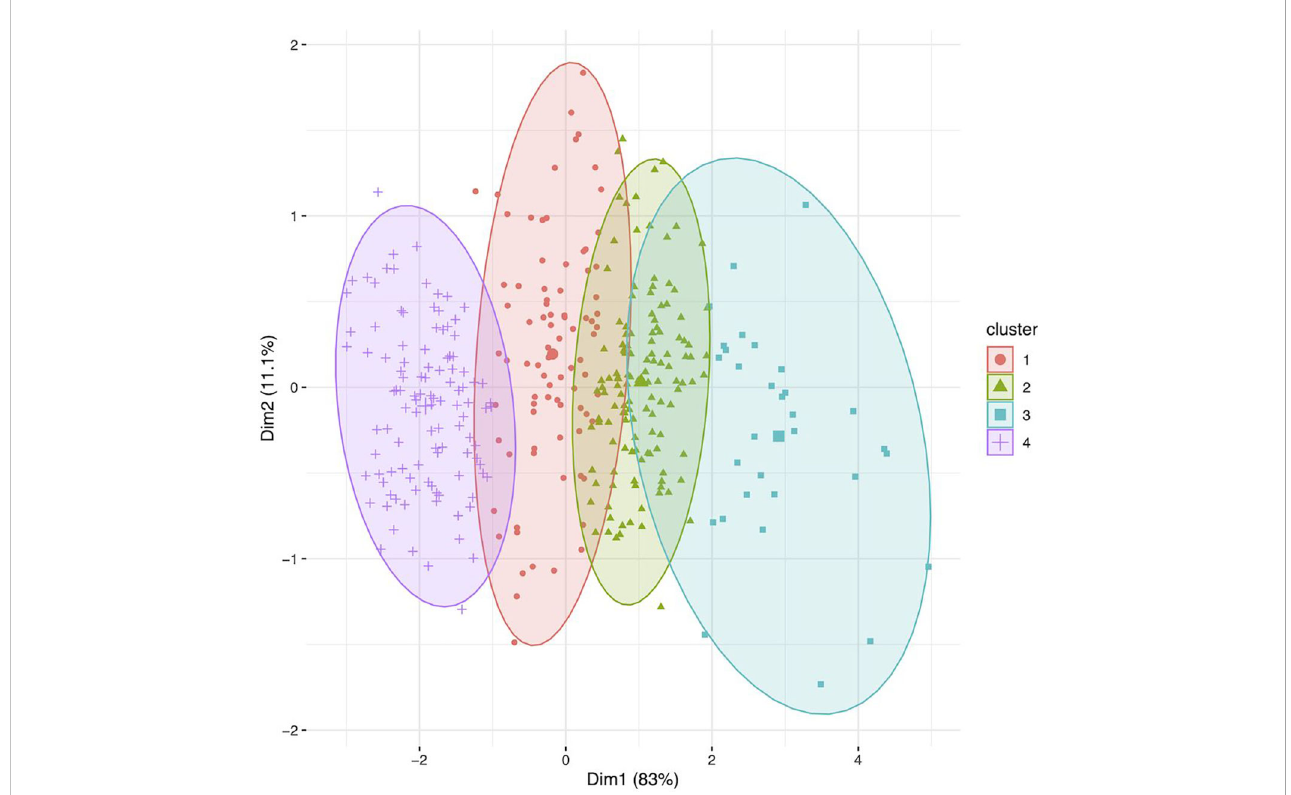
FIGURE 4 Clustering (K-means; groups = 4) of the genotypes (n = 360) using data for days to harvest, height at harvest, and yield/plant. Cluster identity for each accession is provided in Supplementary Table S4 under column 3TC (i.e. three trait cluster), and passport data for each accession is provided in Supplementary Table S1. Cluster 4 includes all the variety trial (VT) entries ( N = 26 ) from the Washington State University (WSU) quinoa breeding program, along with 86 accessions from the world core collection (WCC). Clusters 1, 2, and 3 were comprised of accessions from the WCC. When compared to the mean value for VT entries, 14 accessions in cluster 4 had shorter mean days to harvest, 35 accessions from cluster 4 and 3 accessions from cluster 3 had shorter average height at harvest; and 16 accessions from cluster 4 had greater average yield per plant. Seven WCC accessions satis fi ed each of these conditions. These accessions include PI-634923, PI-614889 (a parent of most of the WSU experimental lines), D-11889, Titicaca (WCC seed source), Vikinga, BO-3 and Moroccan